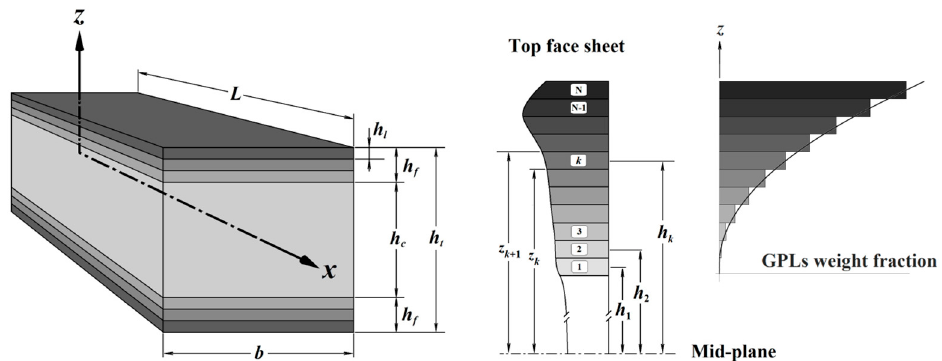
Figure 1. General configuration and graphene nanoplatelet (GPL) dispersion description in a laminated GPL-reinforced sandwich beam.